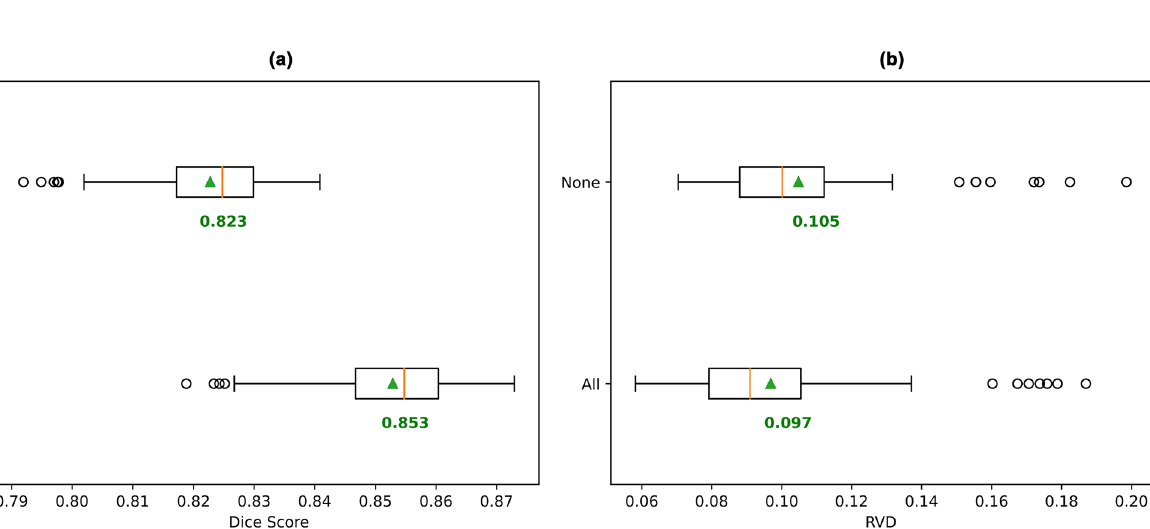
Figure 4. Comparison of UNet3+ trained with and without skip connections. Box plots of ( a ) the mean Dice scores for all subjects (higher is better), and ( b ) the mean RVD values for all subjects (lower is better). Mean across all subject scores is indicated by green triangle and text. Orange bar indicates median score.